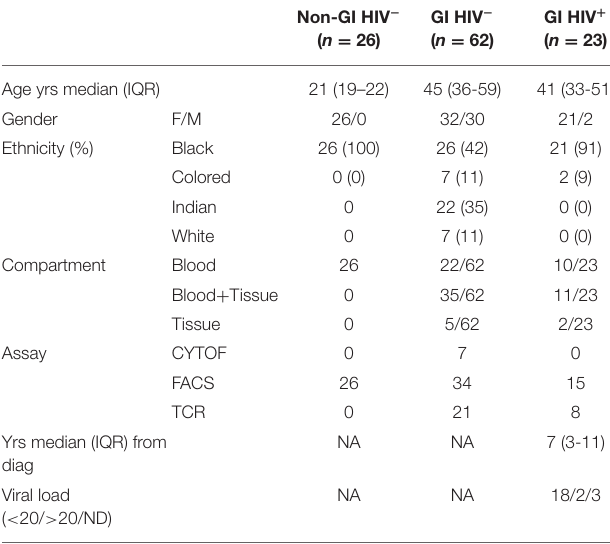
TABLE 1 | Clinical characteristics of n = 111 individuals used in